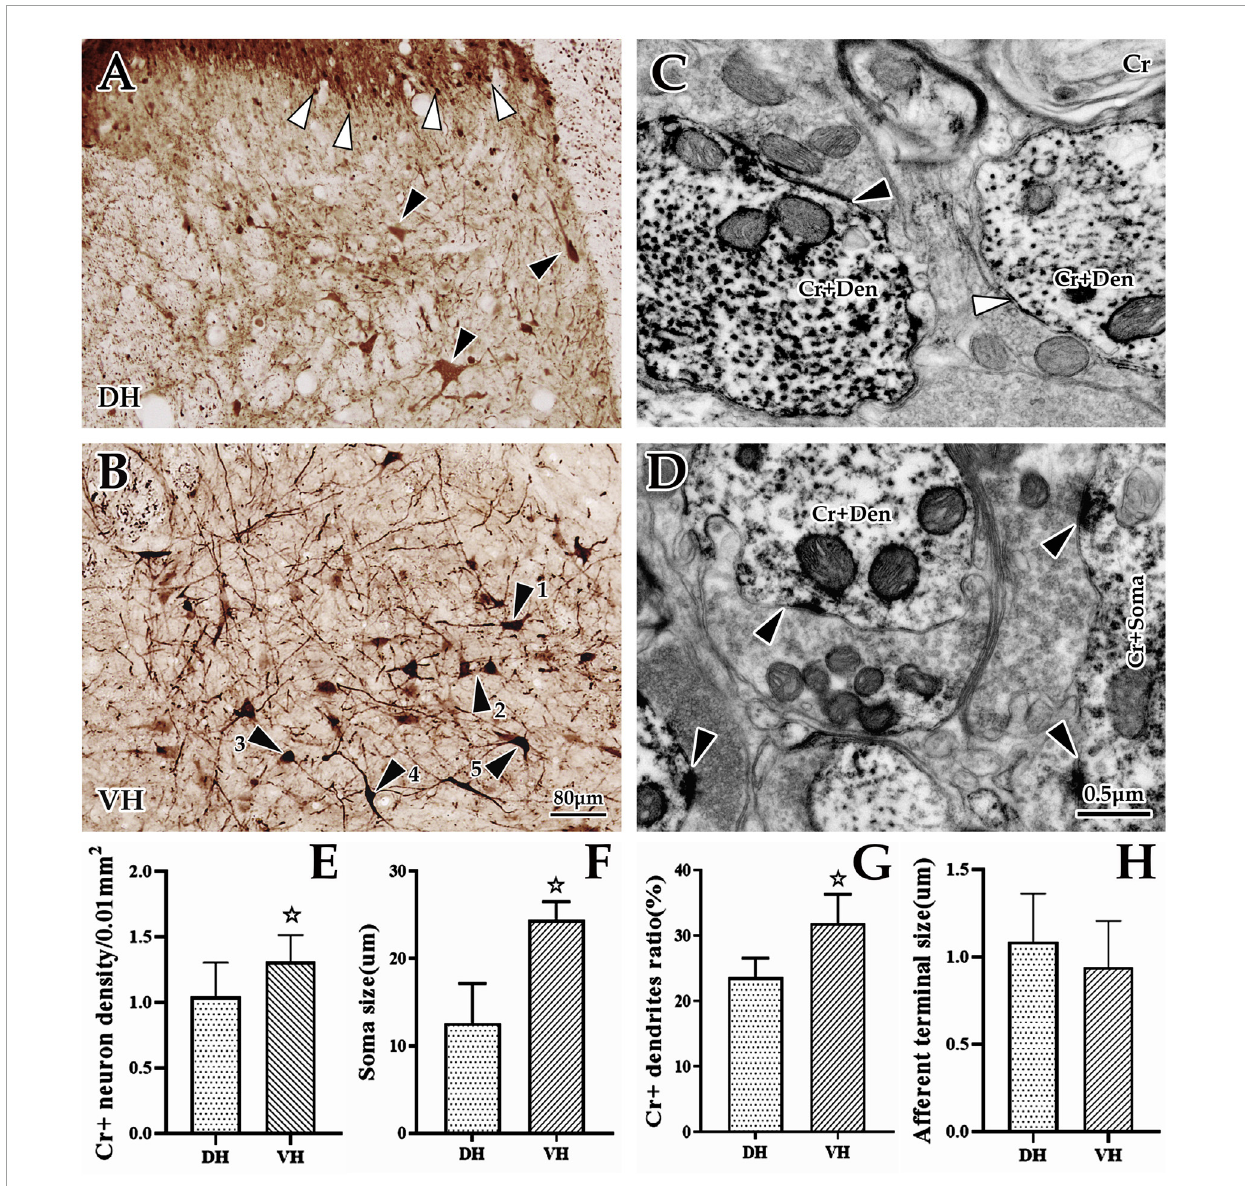
FIGURE3 Morphological and distribution characteristics of spinal Cr+ neurons. The panels above show immunohistochemical single labels of Cr+ neurons (brown) in the dorsal horn (DH) (A) and ventral horn (VH) (B) , in which Cr+ neurons showed a densely banded distribution in the superficial dorsal horn (layers I and II), with tiny spherical somas and rare processes ( (cid:78) ), but in the deep dorsal horn (layers III–VI), they were sparsely distributed, with larger irregular cell bodies and more processes [ (cid:78) , (A)] . In the VH (B) , Cr+ neurons showed a dense distribution with larger cell bodies and bushy processes. These Cr+ neurons appeared to have various shapes: some of them were polygonal and pyramidal ( (cid:78) 1 and (cid:78) 2), and others were spherical, fusiform and semilunar ( (cid:78) 3, (cid:78) 4, and (cid:78) 5). (C,D) Show the ultrastructure of Cr+ neurons at the immuno-electron microscope (EM) level. A large number of Cr+ dendrites (C) and somas (D) with asymmetric synaptic inputs ( (cid:78) ) were clearly visible, but some were visible for symmetric synaptic inputs [ (C) , (cid:78) ]. The abbreviations in this figure are the same as in Figure 2 . Light microscope (LM) images were obtained at the same magnification; scale bar = 80 µ m. The magnification of the EM images is the same as the scale bar in the right lower corner of (D) . Histograms (E,F) show the density and soma size of Cr+ neurons in the DH and VH for immuno-LM experiments, respectively. Histograms (G,H) show the labeling rate and size of Cr+ dendrites in the DH and VH for immuno-EM experiments, respectively. P < 0.05, compared between the DH and VH.